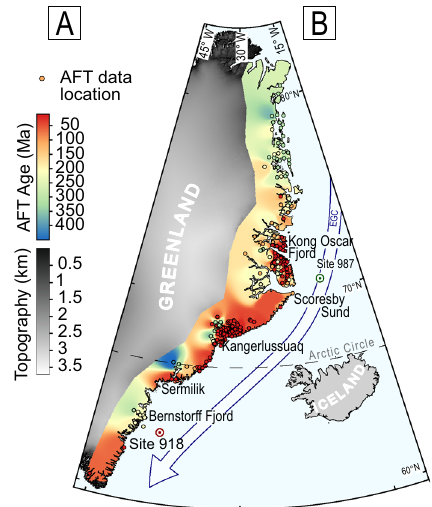
Figure 1. ( A ) DEM of eastern Greenland with interpolation map of in situ fission track ages. Locations of ODP sites used in this study and East Greenland Current are shown. The map was created from GIMP data 14 using QGIS 3.x